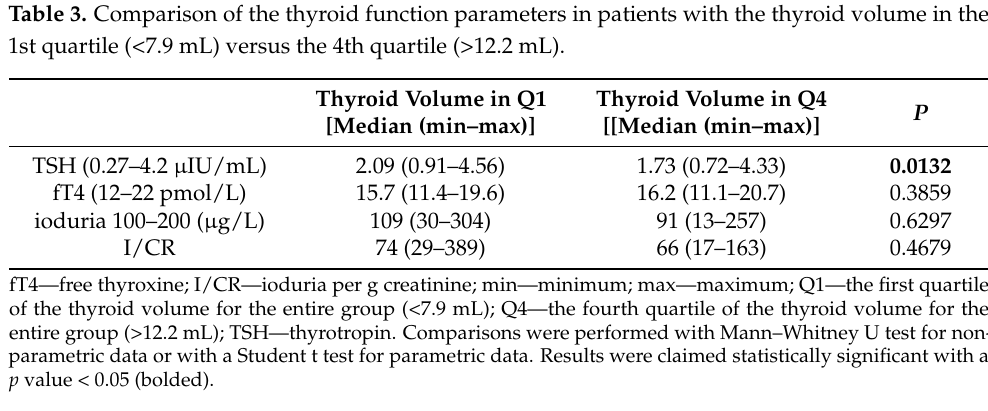
Table 3. Comparison of the thyroid function parameters in patients with the thyroid volume in